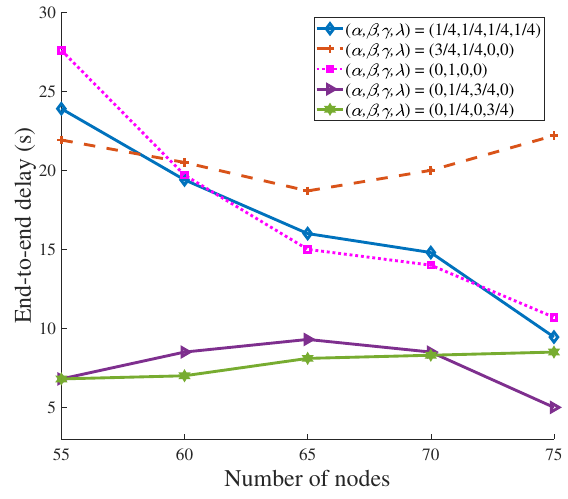
Figure 6. End-to-end delay of